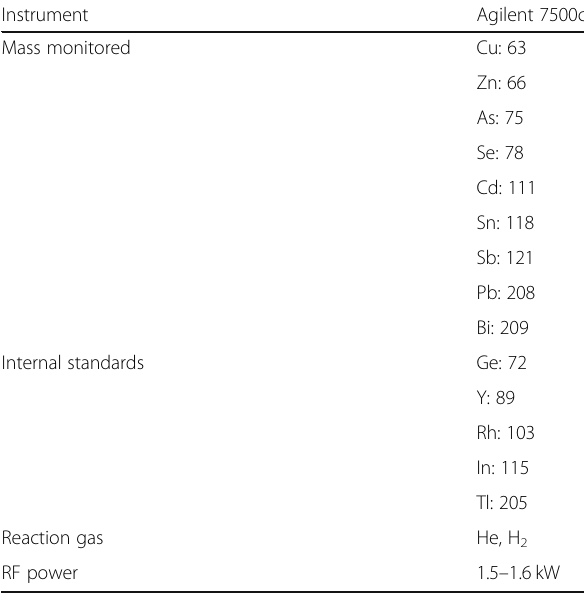
Table 1 Instrumental setting for ICP-MS Instrument Agilent